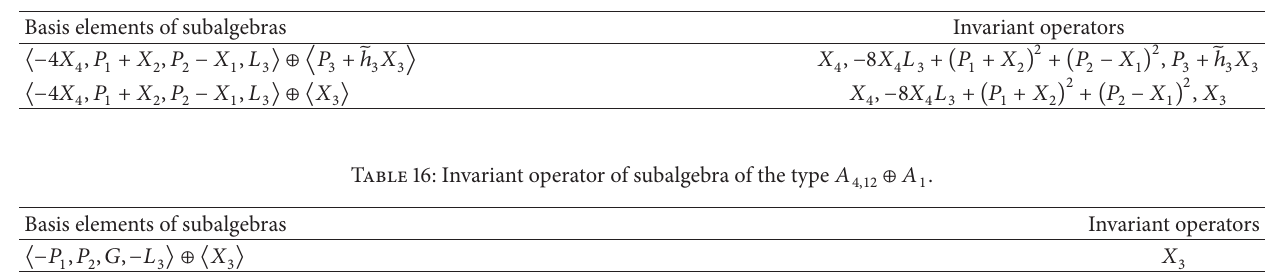
Table 15: Invariant operators of subalgebras of the type 𝐴 4,10 ⊕ 𝐴 1 .